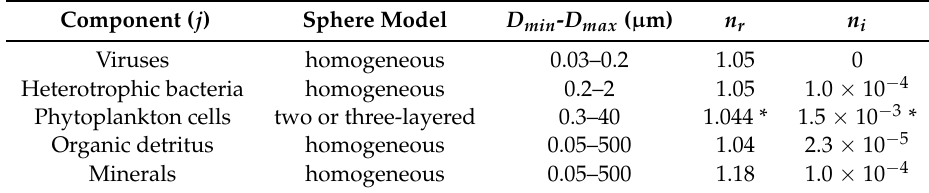
Table 1. Summary of the seawater